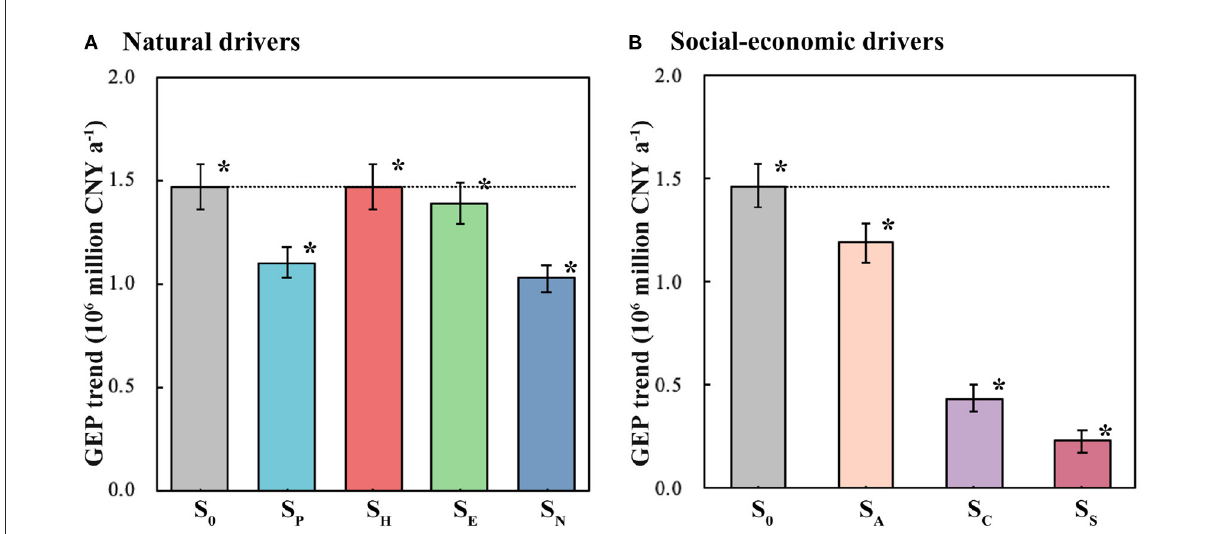
FIGURE3 Effects of (A) natural and (B) social-economic drivers on GEP. S 0 , S P , S H , S E , S N , S A , S C , and S S represent the scenarios of normal, no variation in precipitation, high-temperature days, evapotranspiration, all three natural factors, planting area, product prices, and two social-economic factors, respectively. The dotted lines indicate the value of S 0 . * indicates significance at the 0.05